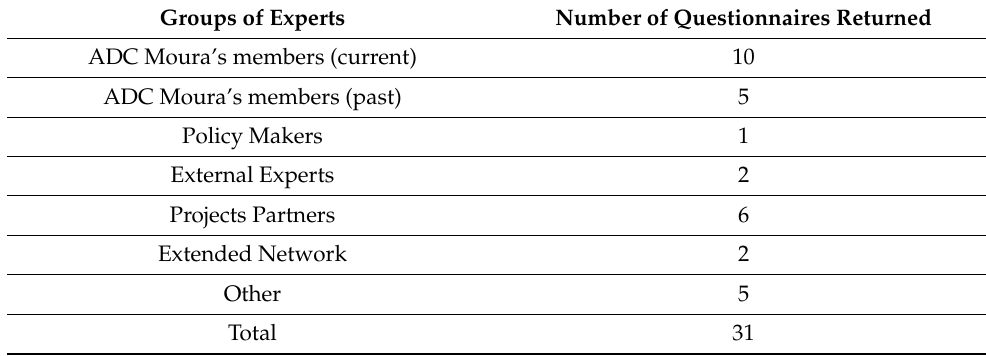
Table 3. Number of responses by group. Source: author’s own